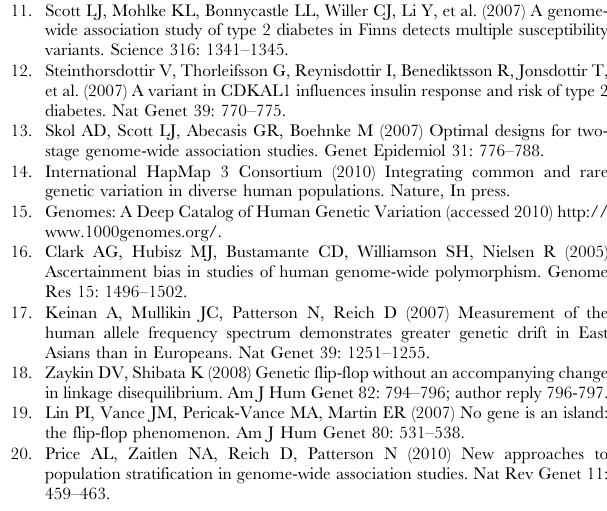
Figure S1 Number of monomorphic SNPs in the HapMap 3 population panels. The number of monomorphic SNPs in each population panel are displayed, stratified by minor allele frequency in CEU. Figure S2 Power to detect an association for common alleles (5– 10%) based on HapMap 3 data. The impact on power of switching to non-European samples in stage 2 of the GWAS is limited primarily to alleles of lower frequency in CEU. Testing non-European samples for alleles of common frequency in CEU yields a small (or no) increase in power. Figure S3 Power to detect an association for common alleles (5– 10%) based on 1000 Genomes data. Consistent with our observations in the HapMap data, the improvement in power achieved by using non-European samples is limited to alleles of lower frequency in CEU. Table S1 Power to detect an association for a sample size of 10,000 using HapMap 3 data. Power is aggregated over all 1.4 million SNPs, over lower-frequency (1–5%) alleles, and over subsets of SNPs stratified by minor allele frequency in CEU. Calculations were made using allele frequencies from all 11 HapMap 3 population panels. GRR is varied between 1.1 and 1.5. Data points referred to in the paper and in figures appear in bold. Table S2 Power to detect an association for a sample size of 20,000 using HapMap 3 data. Calculations were made using HapMap 3 data. Data points referred to in the paper and in figures appear in bold.